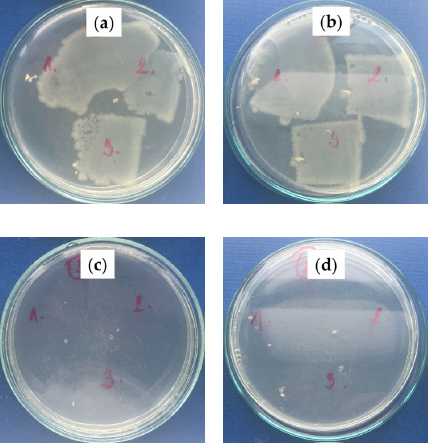
Figure 9. Total bacterial counts on plate-count agar with inoculated E. coli : ( a ) PS/PDMS-PE, ( b ) PS/PDMS-PU, ( c ) PS/PDMS/BSO-PE, ( d ) PS/PDMS/BSO-PU; numbers represent various imprint